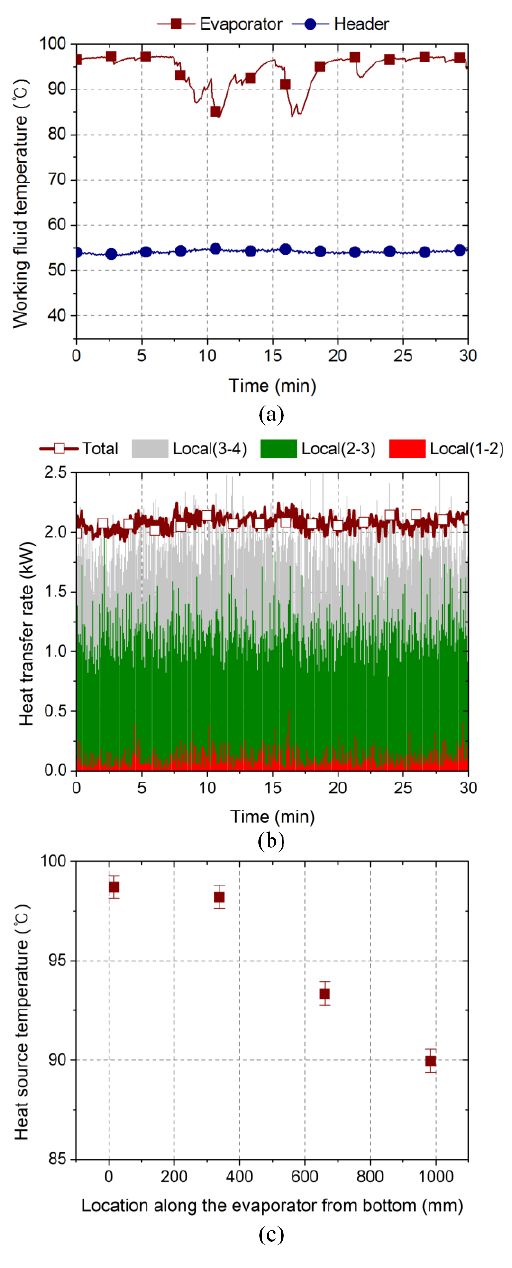
Figure 19. Operating characteristics of an FHP with a heat source temperature of 98.1 °C: ( a ) working fluid temperature, ( b ) cumulative heat transfer rate, and ( c ) local heat source temperature.